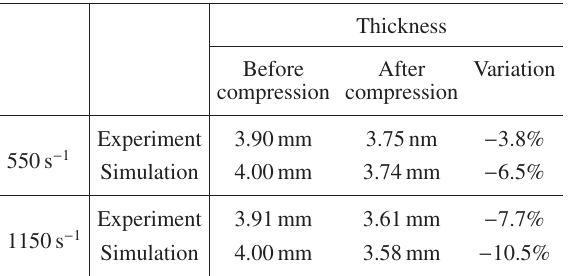
Fig. 12. Comparison of thickness histories and diameter histories. Table 4. Comparison of thickness between before and after compression.